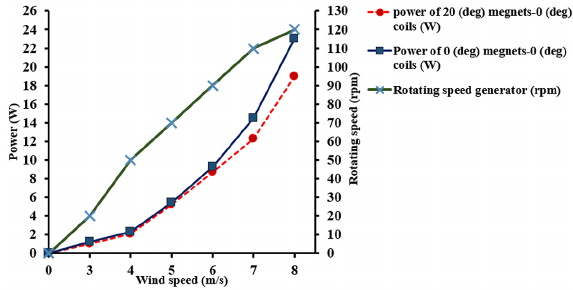
Fig. 4. Comparison of skewing magnets at 0, 5, 10, 15 and 20 degrees and starting torque for cut-in of the VAWT at different wind speeds.